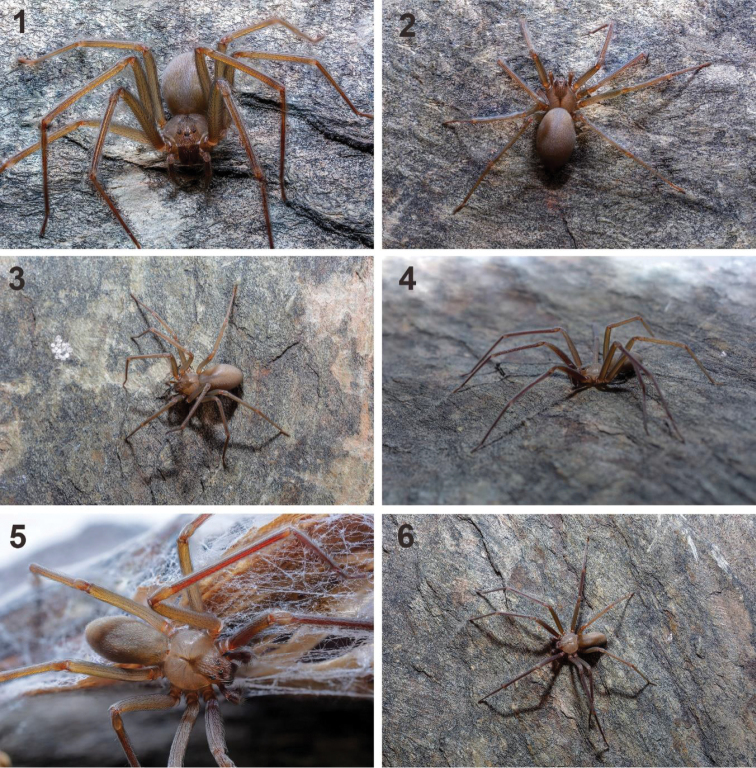
Live specimens of Loxosceles
tenochtitlan sp. nov. from Street Juárez Norte #214, Huamantla, Municipality Huamantla, Tlaxcala, Mexico 1–3 females 4–6 males. Photographs by Jared Lacayo-Ramírez (2019).